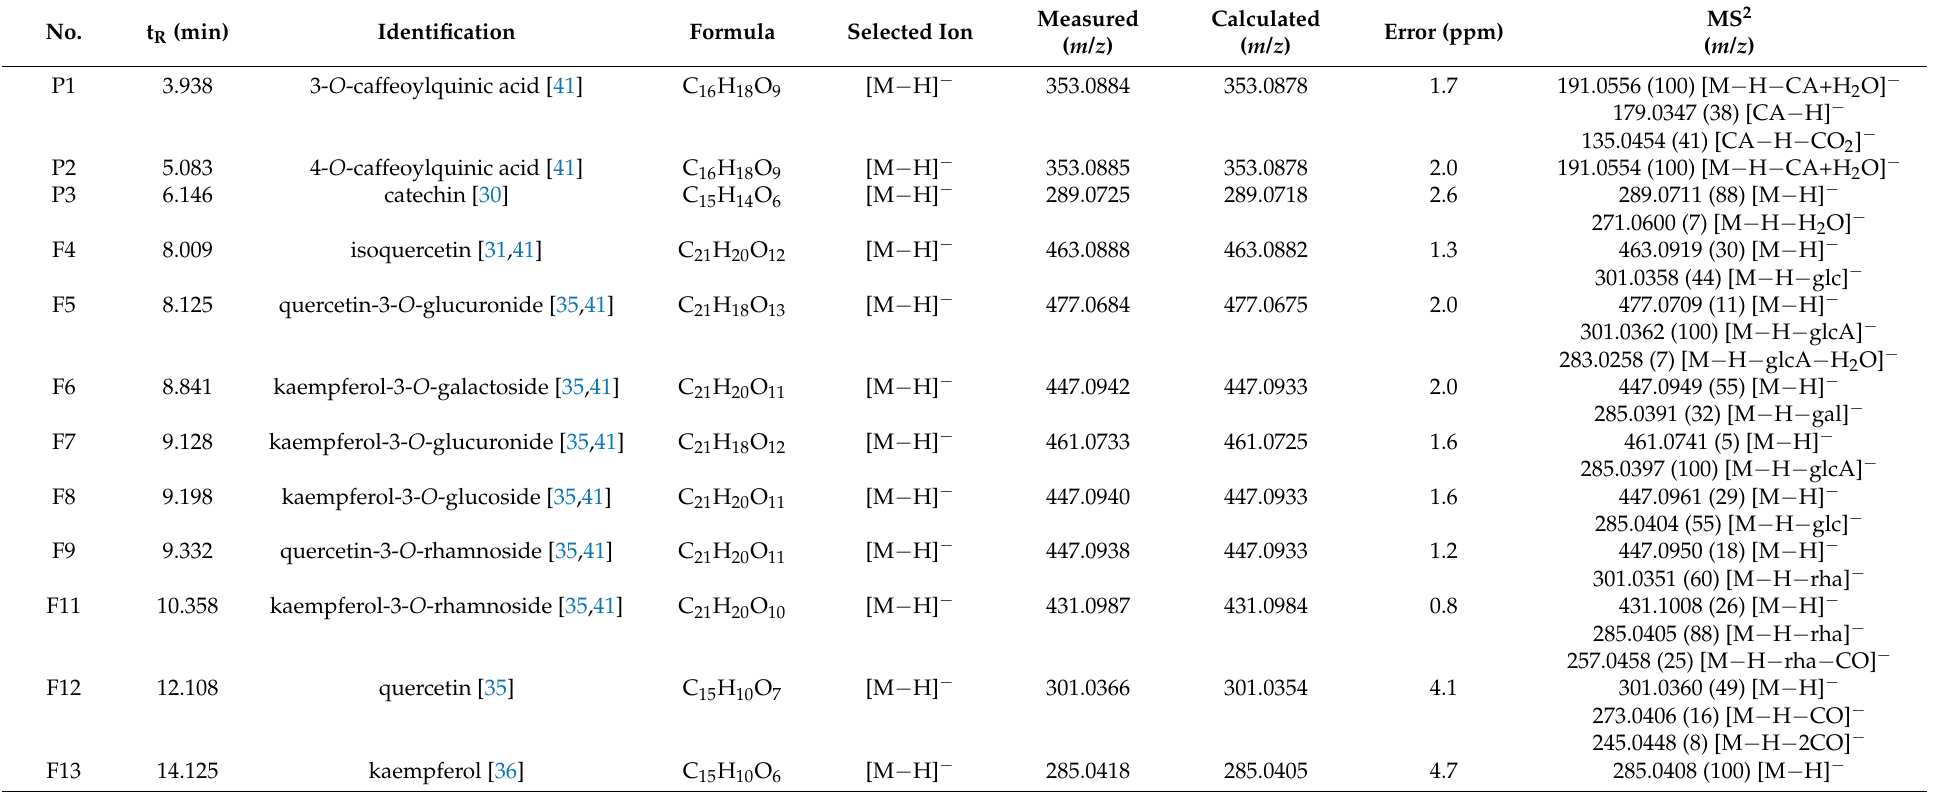
Table 2. Identification of the chemical constituents in CPF by HPLC-ESI-Q-TOF-MS/MS.